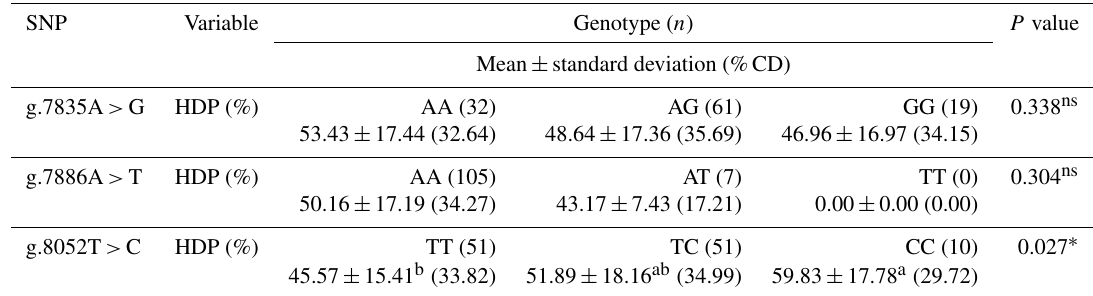
Table 2. Association of the prolactin SNP gene with egg production in IPB-D1 chickens. SNP Variable Genotype ( n ) P